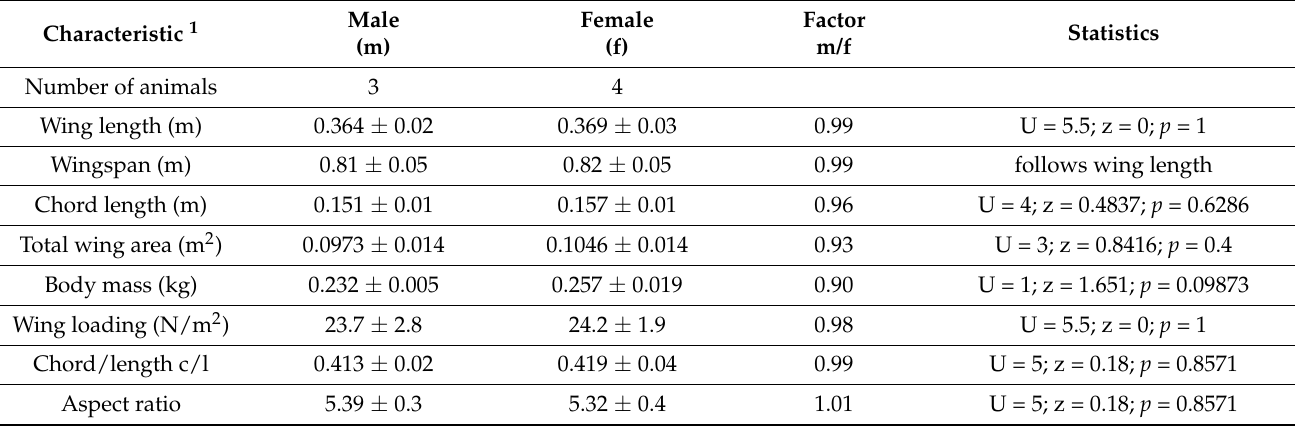
Table 4. Morphometric characteristics of Barn-owl wings: Data of Tyto furcata puncatissima